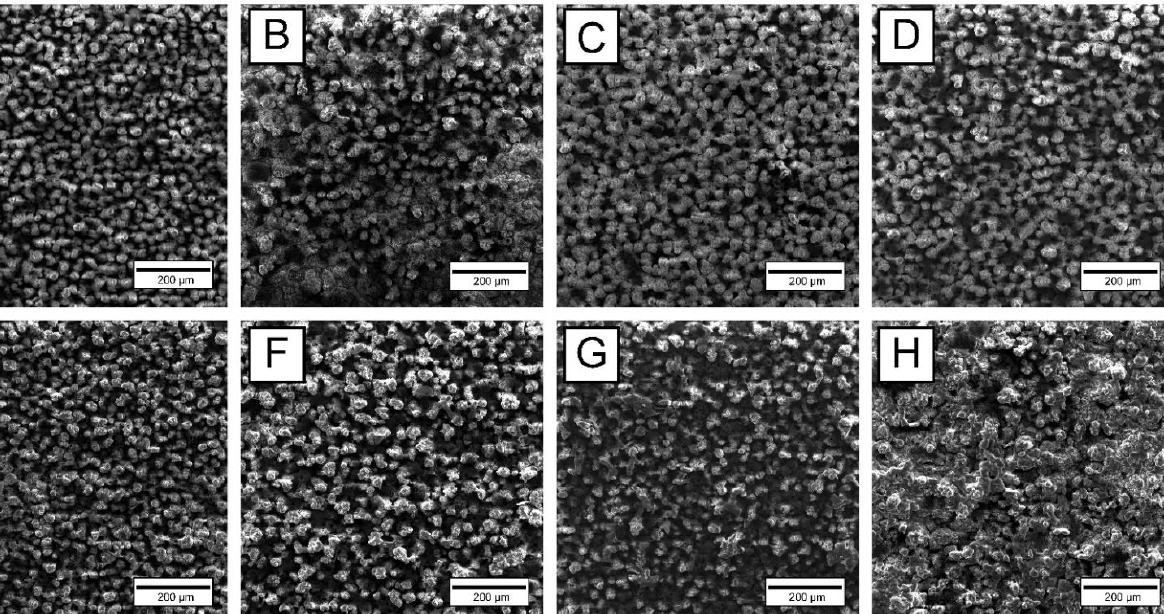
Table 3. Thickness and roughness of MAO coatings before (bT) and after (aT) TCT.